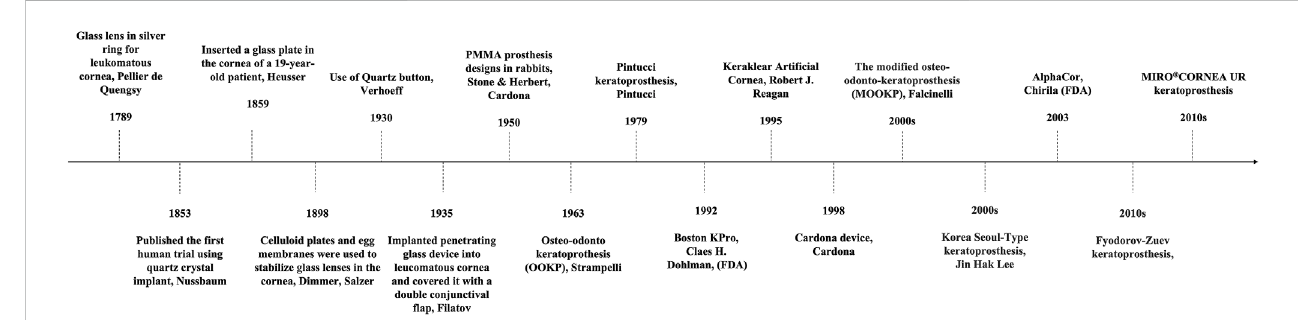
FIGURE 1 Milestones of corneal transplant including keratoprosthesis development.